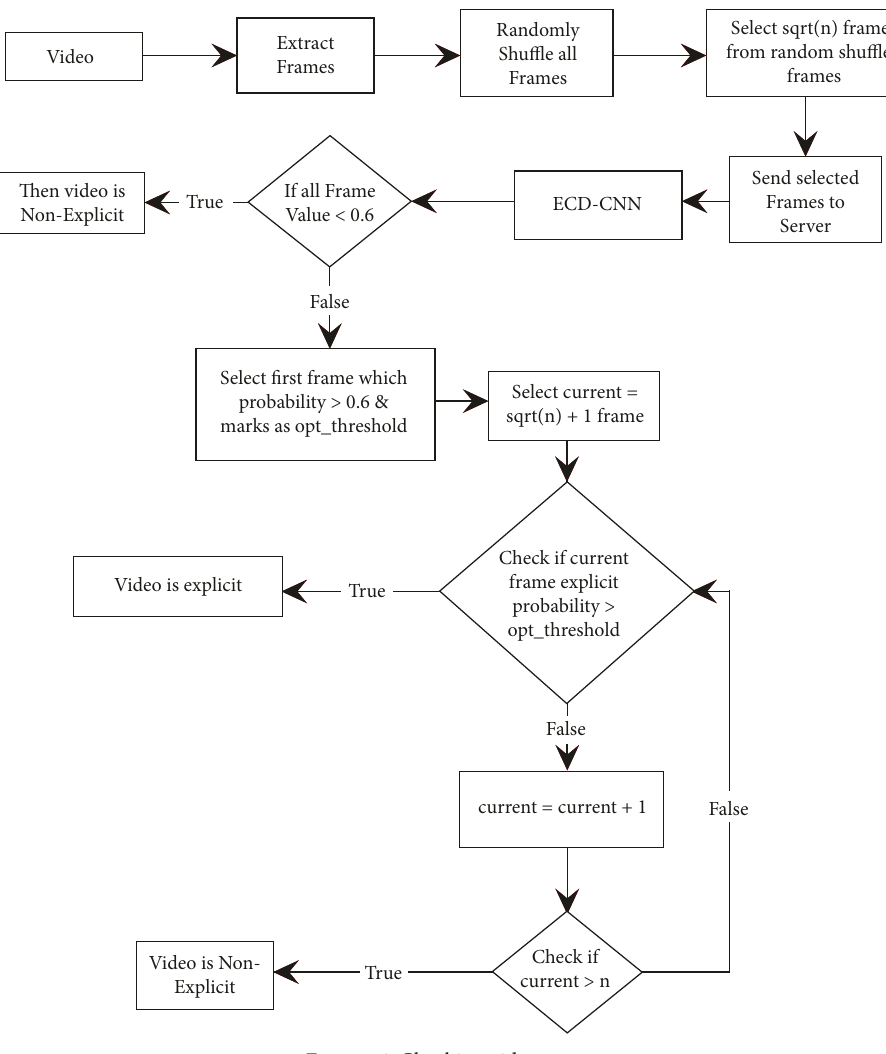
Figure 6: Checking video